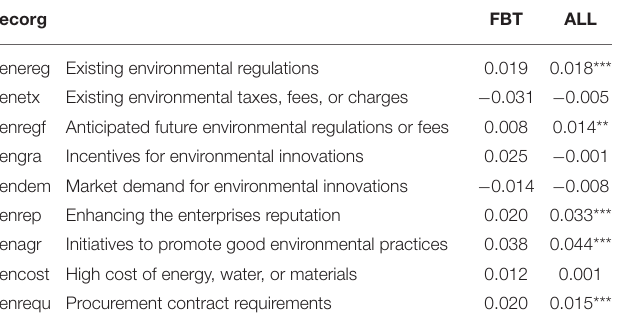
TABLE 8 | Multivariate regression parameters to discover enterprise drivers of circular benefits.